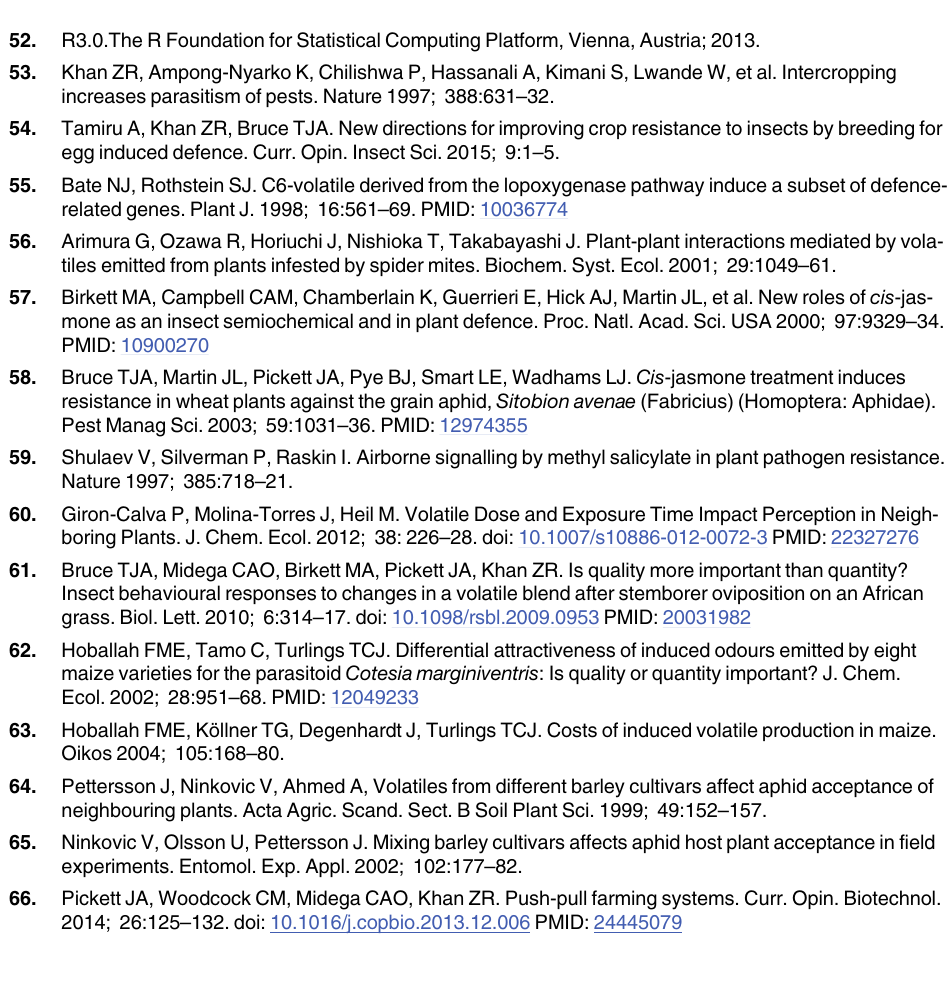
PLOS ONE | DOI:10.1371/journal.pone.0158744 July 8,